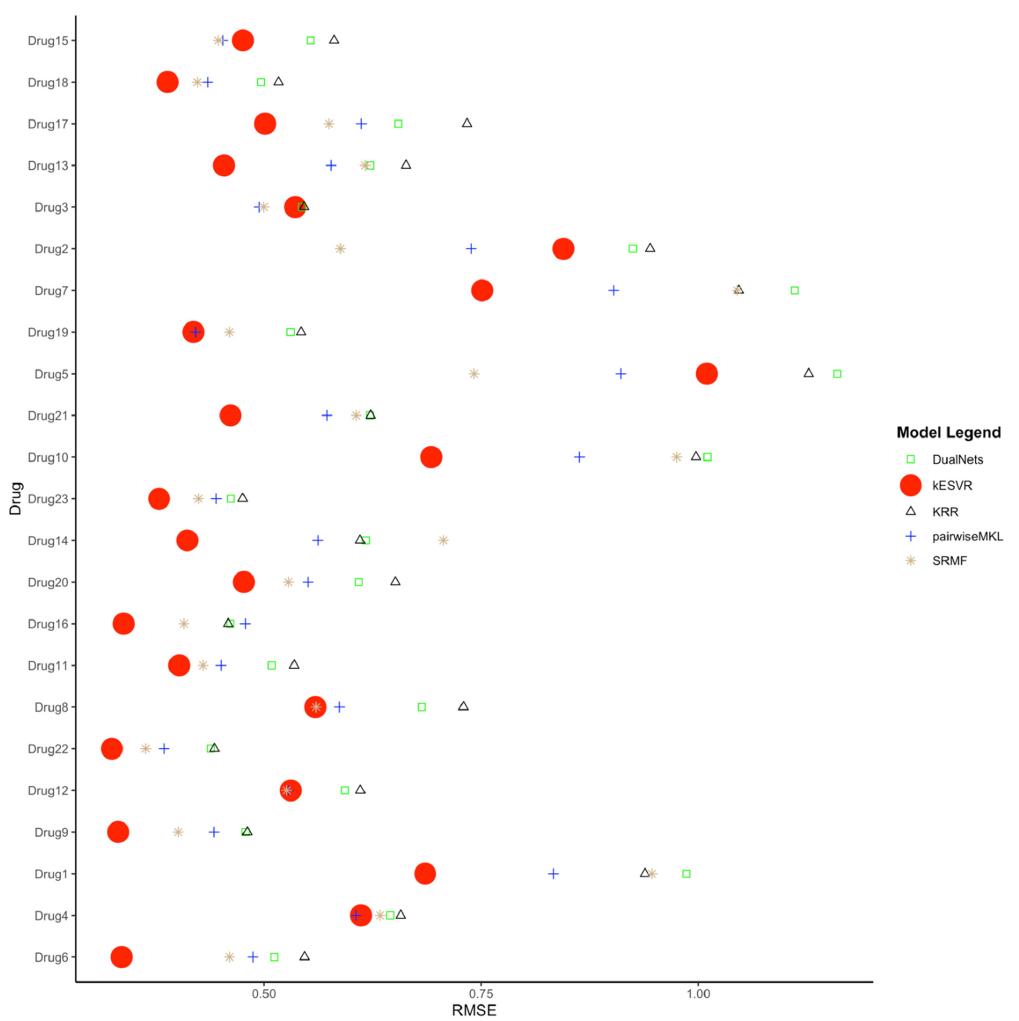
Figure 4. Comparison of kESVR with DualNets, KRR, pairwiseMKL and SRMF models in terms of Root Mean Square Error (RMSE) value over 23 drugs. kESVR is the best performing (lowest RMSE) model in 17 out of 23 drugs. For the remaining 6 drugs, kESVR places in the top 3 position among the 5 models.